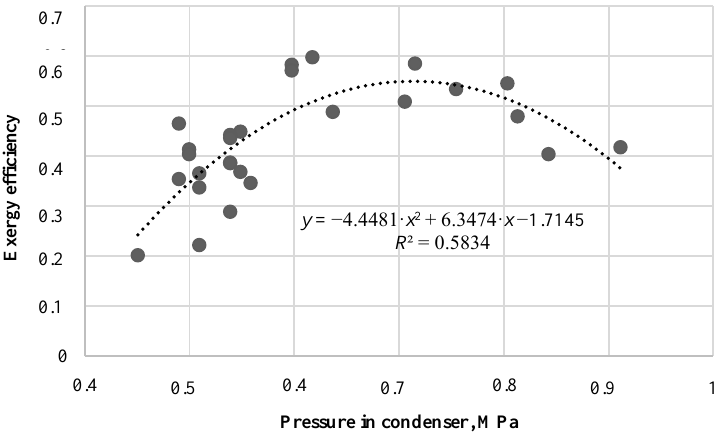
Fig. 3. Single-stage compressor refrigeration system exergy efficiency depending on pressure in